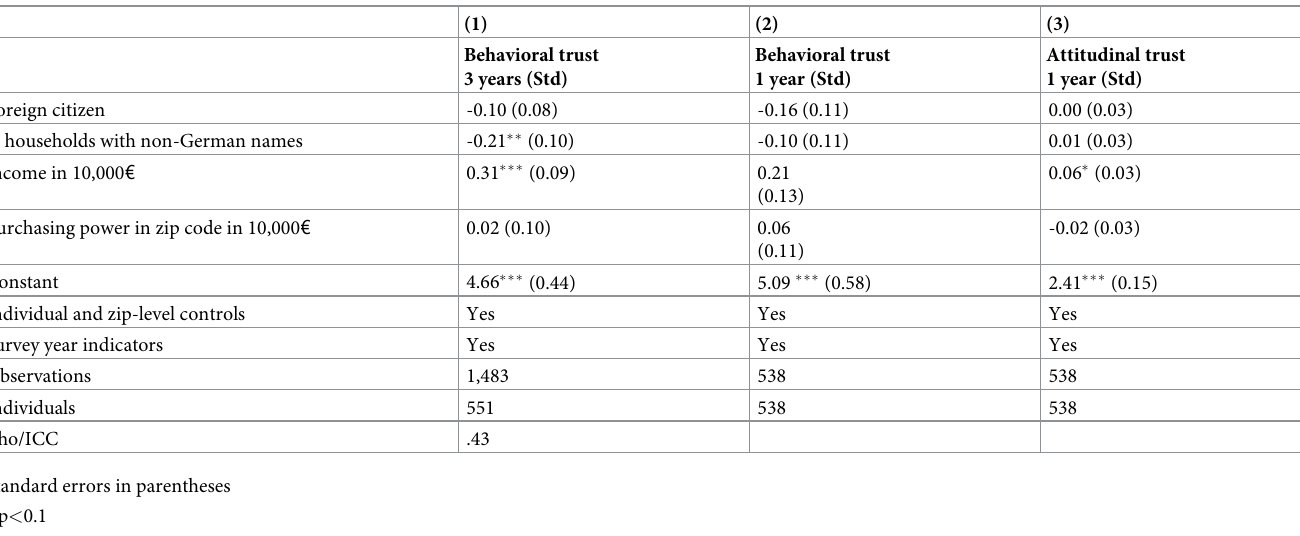
Table 3. Comparing behavioral and attitudinal trust conditional on individual- and zip-code-level indicators of socio-economic status and ethnic